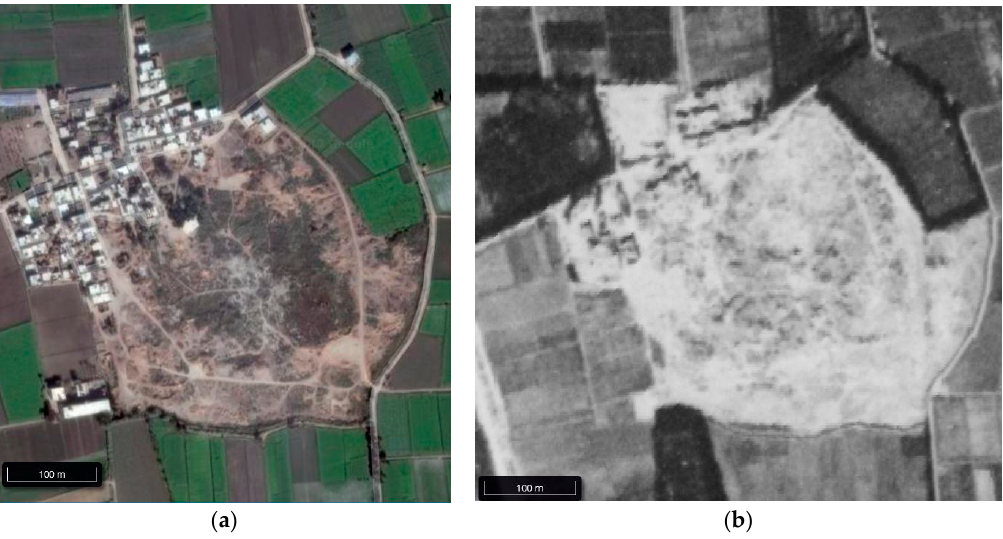
Figure 6. ( a ) The site of Abu el Humar. Image courtesy Google Earth; ( b ) 1968 CORONA image. Image courtesy of the Center for Advanced Spatial Technologies, University of Arkansas/U.S. Geological Survey.